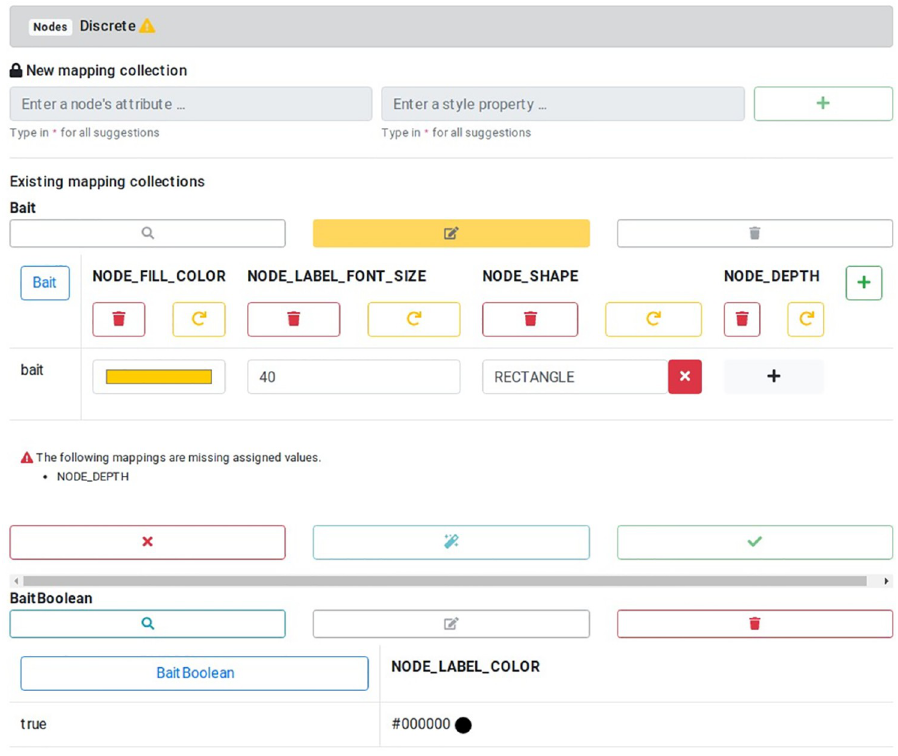
Fig 2. Discrete mapping for node properties. New discrete mappings can be created, existing mappings are shown for the “Bait” property of several visual properties. This includes mappings to colors, numerical and concrete string